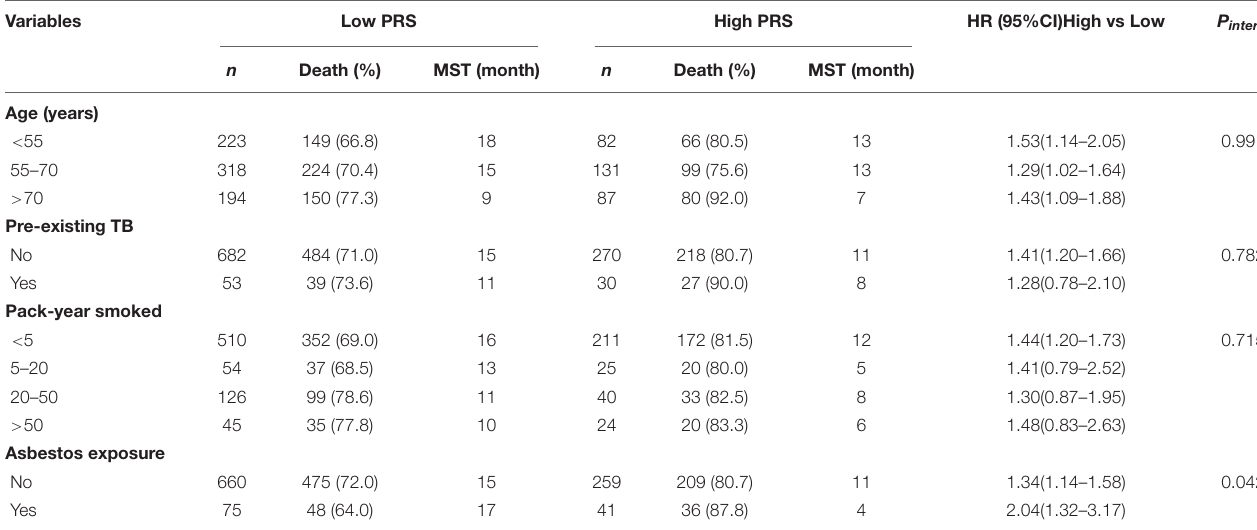
TABLE 2 | Stratification Analysis of the CNV-based PRS and NSCLC survival.